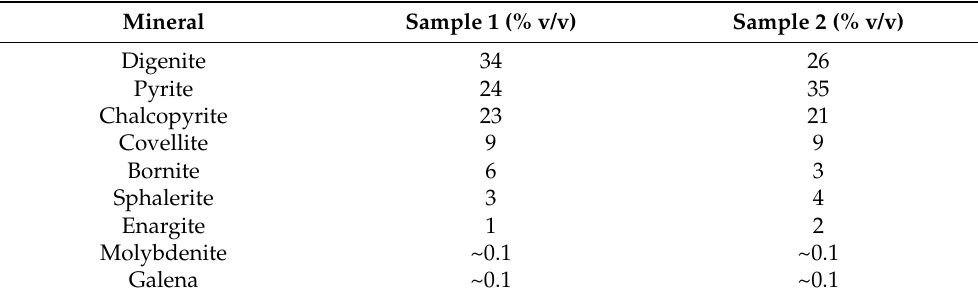
Table 4. Mineralogical composition of concentrates from Chuquicamata mine (% v/v, relative to the total sulfide phase) [52].